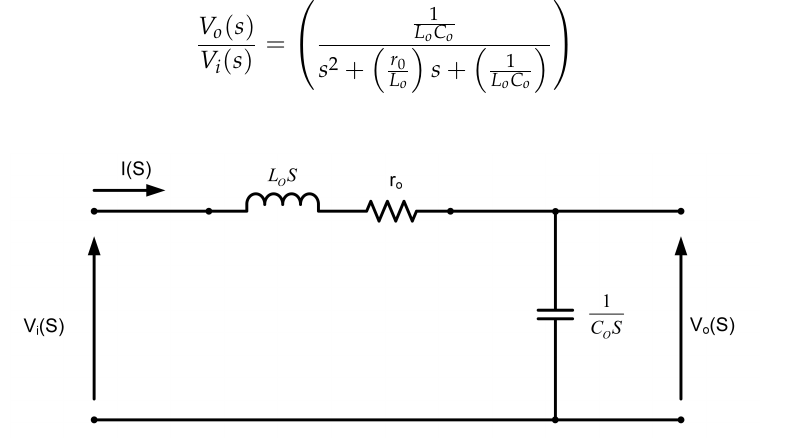
Figure 5. Scheme of the output filter LC